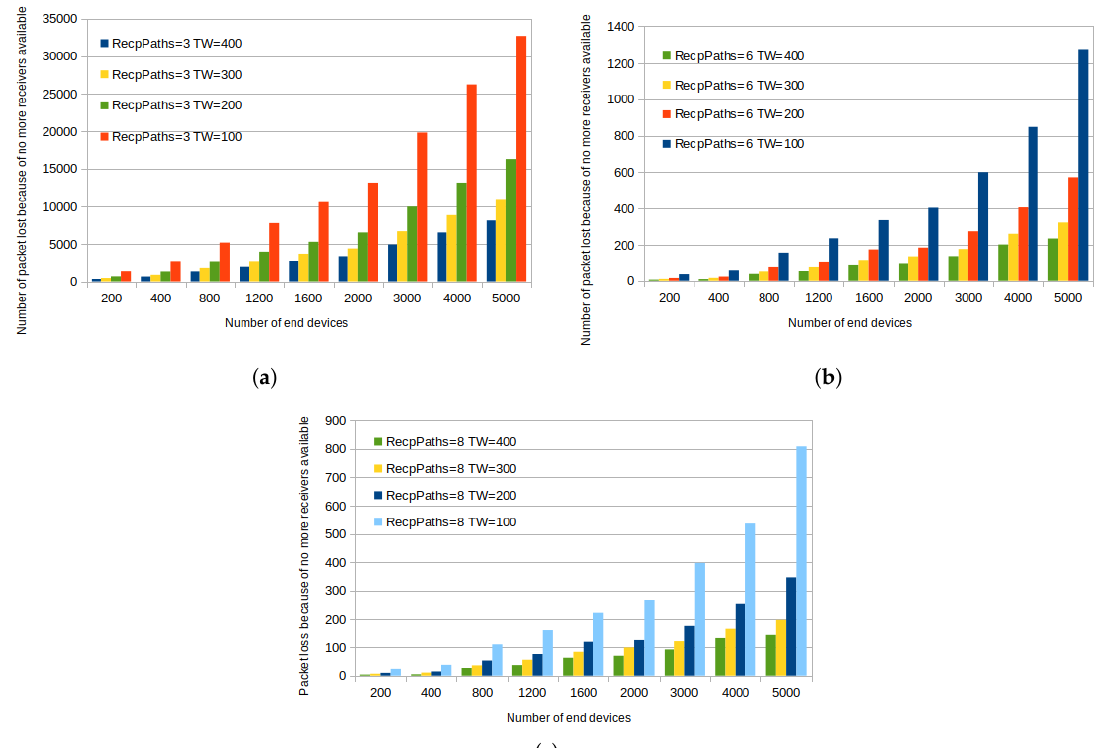
Figure 12. Number of lost packets versus number of EDs. ( a ) Receive Paths = 3; ( b ) Receive Paths = 6; ( c ) Receive Paths =